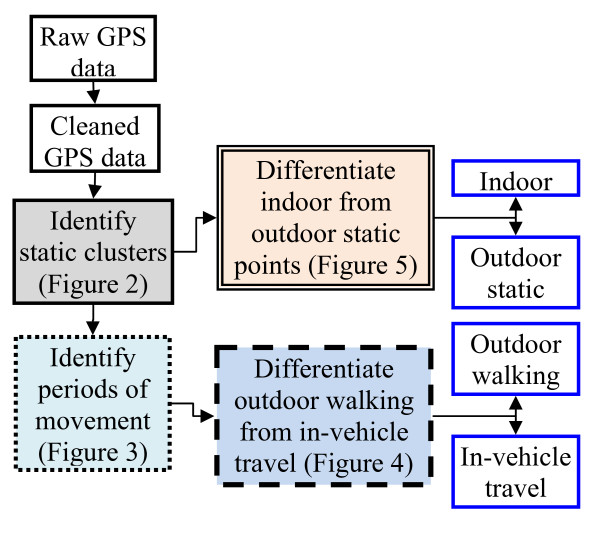
Overall flow chart.